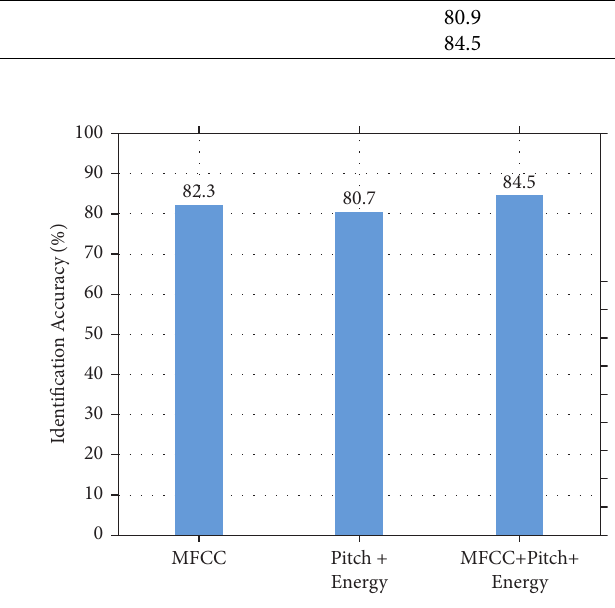
Figure 8: Training performance of speaker identification system with 80% training split of data and varying learning rate values. Table 8: Test performance of speaker and dialect identification systems with the combination of spectral and prosodic features. System